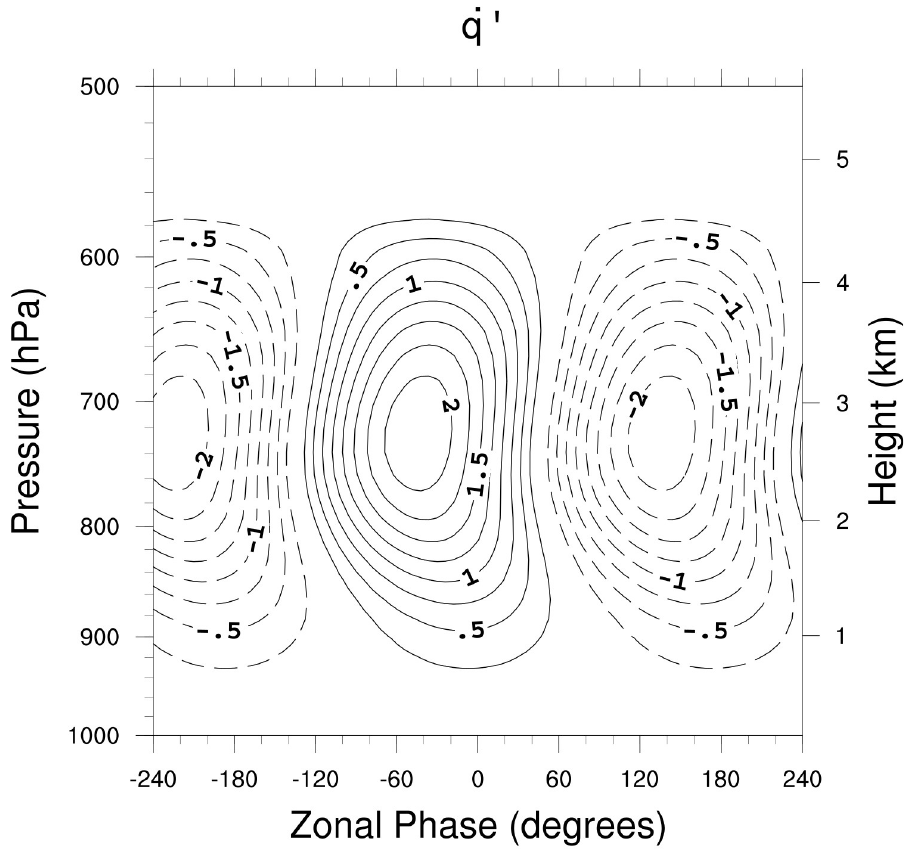
. (cid:48) q , at 18 ◦ N for the active case. Solid (dashed) contours